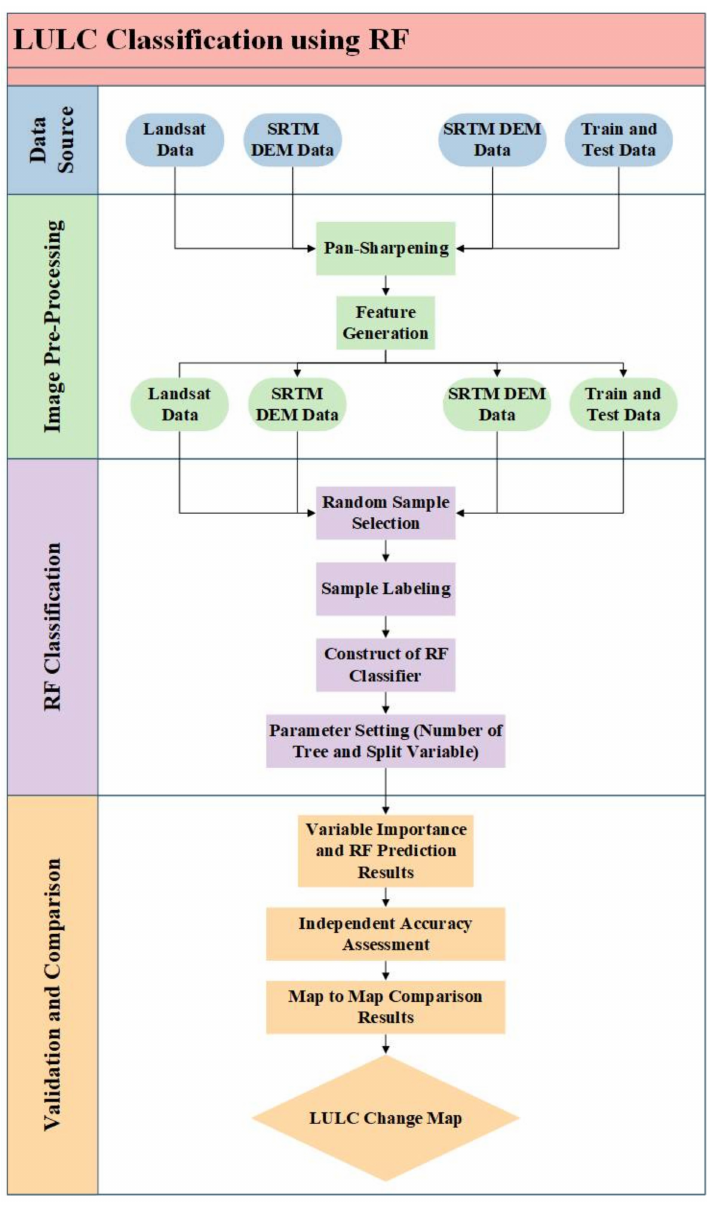
Figure 2. The workflow of LULC classification is based on the RF. Table 4. Extracted features from Landsat